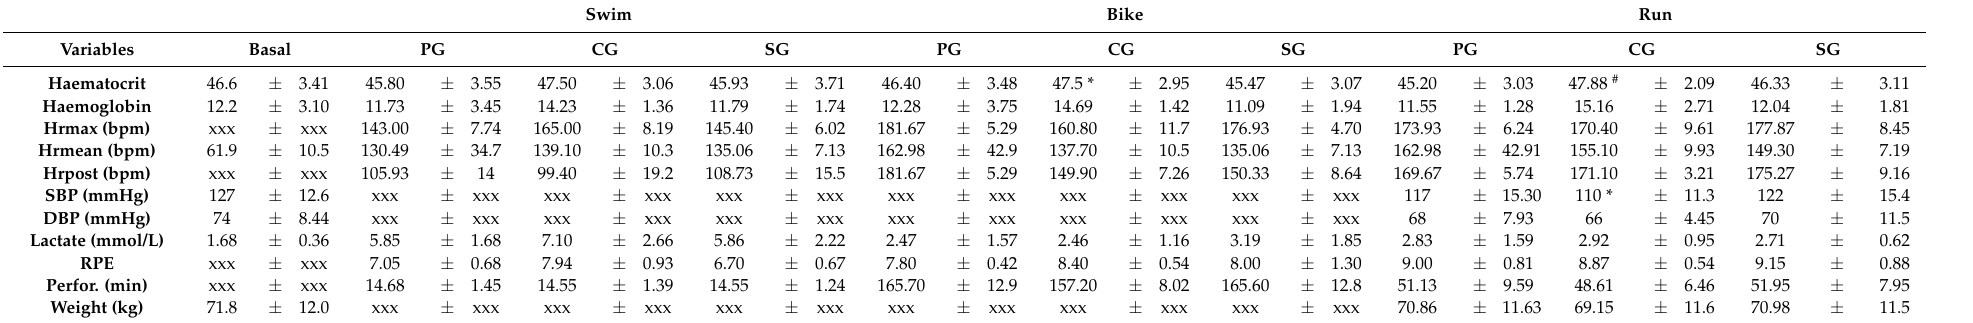
Table 2. Heart rate response, hematological measurements, and stress